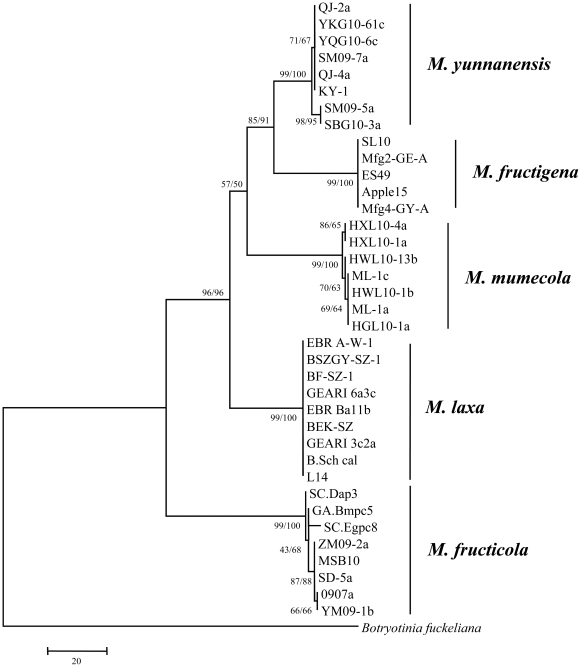
Phylogeny of 38 isolates of Monilinia spp. and Botryotinia fuckeliana.Maximum parsimony (MP) tree inferred from the data set containing the combined DNA sequences of G3PDH and TUB2, with 2215 characters, 172 of which were informative. The numbers labeled at each node indicate the bootstrap (BS) percentage (N = 1000): BS value from the MP test/BS value from the neighbor-joining (NJ) test.